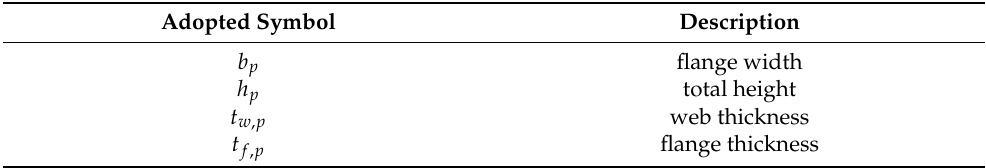
Figure 1. Typical standard I-shaped steel profile. Table 1. Geometrical characteristics of the standard steel profile.